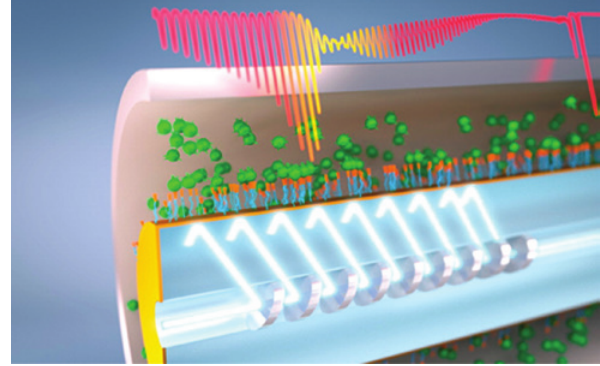
Figure 8: Sensor architecture of a gold-coated TFBG operating in